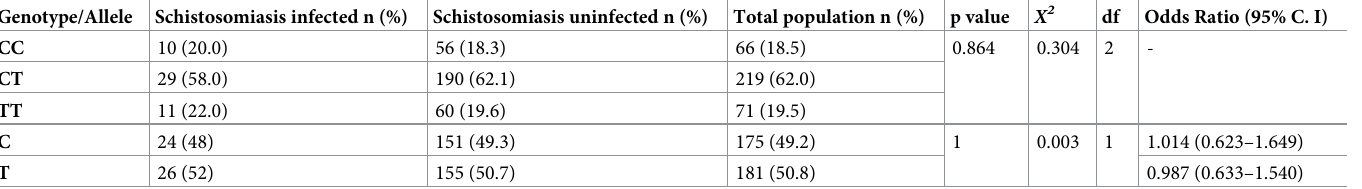
Table 2. Distribution and association of IL-13-1112C/T genotype and allelic frequencies in schistosomiasis infected and uninfected participants. Genotype/Allele Schistosomiasis infected n (%) Schistosomiasis uninfected n (%) Total population n (%) p value X 2